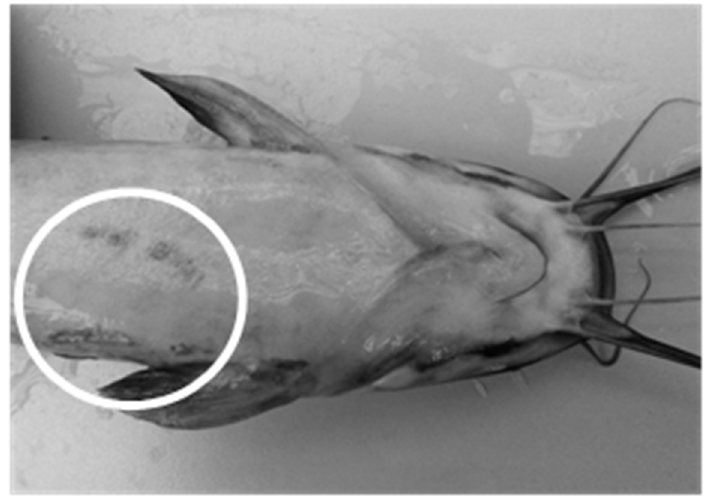
Figure 3. Skin damage with obvious teeth marks and the typical jaw form of C. gariepinus , the result of an intraspecific fight. Photo processed with amplified contrast (+20%).